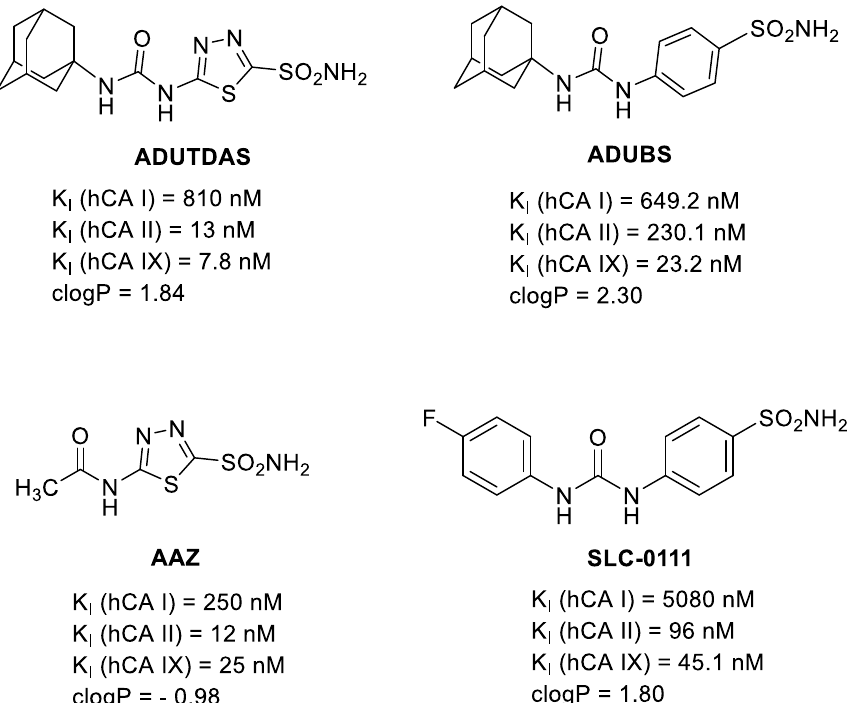
Figure 4. CA IX inhibitors used in this study [26,57,67,68,70], having different potencies against CA I, CA II and CA IX isozymes and different lipophilicities.